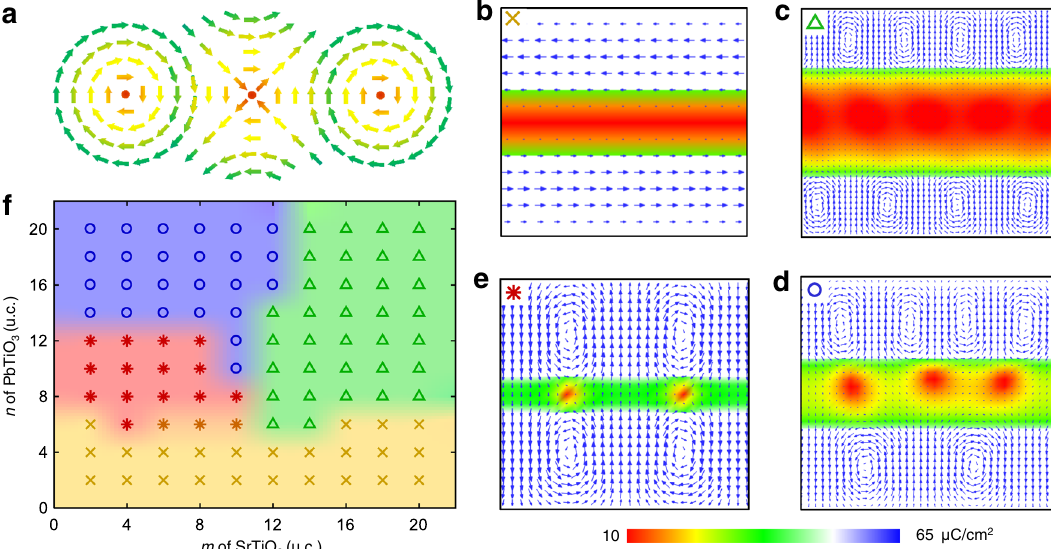
Fig. 1 Designing vortex – antivortex pair in (PTO) n /(STO) m superlattice. a Schematic illustration of a topological antivortex sandwiched between two adjacent vortices. b – e Four typical polar structures exist in (PTO) n /(STO) m superlattices for different combinations of m and n , as predicted by phase- fi eld simulation. b For 4-u.c. thick STO ( m = 4) sandwiched between two 4-u.c. thick PTO ( n = 4), antiparallel a -domain is observed in PTO, while polarization in STO is negligibly small, exhibiting no nontrivial topological structure. c For m = 20 and n = 10, vortex array emerges in PTO, while polarization in STO remains negligibly small. d For m = 10 and n = 10, sign of topological structure appears in STO, with modestly increased polarization, while antivortex appears irregular. e For m = 4 and n = 10, perfect antivortex array with relatively large polarization is observed in STO, sandwiched between two vortices in adjacent PTO. f Phase- fi eld computed phase diagram of four typical polar structures in (PTO) n /(STO) m superlattices, as represented by b – e